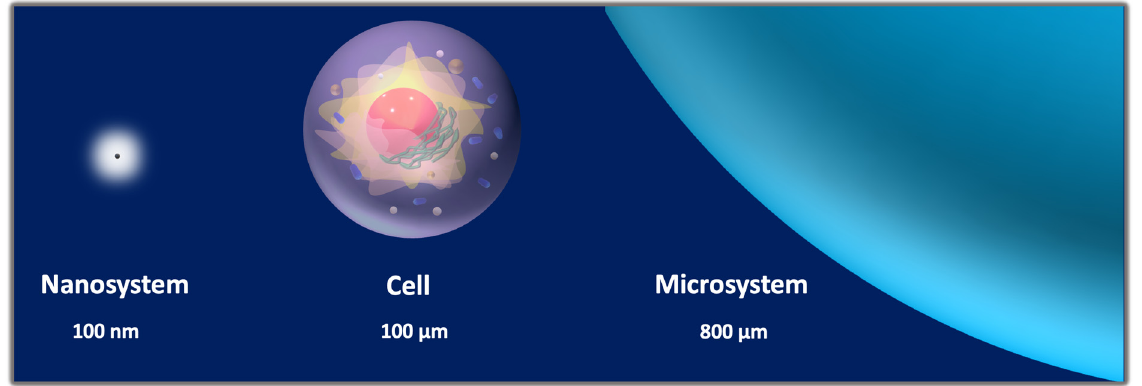
Figure 3. Nano to micro-scale. Comparison among the typical size of nanosystems, microsystems, and cells: nanoparticles have diameters comprised between 1 and 100 nm; microparticles have diameters ranging from 1 µ m to 1000 µ m, whereas the diameter of cells can vary from 10 to 100 µ